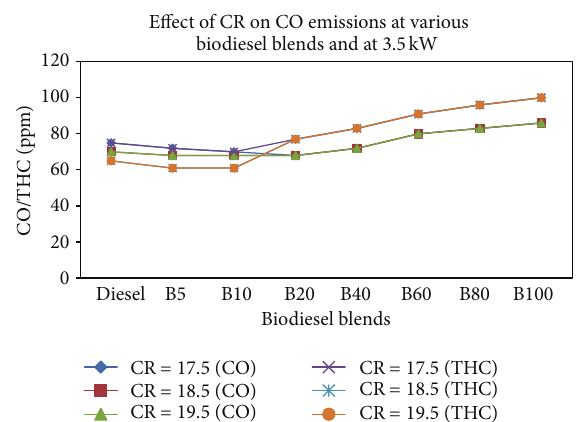
Figure 13: Variation in CO and THC for various biodiesel blends at compression ratios 17.5, 18.5, and 19.5.